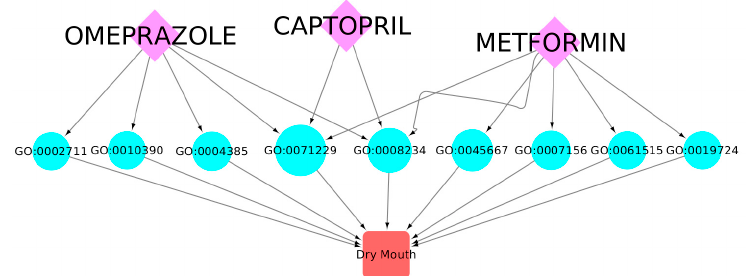
Figure 13. A subgraph of omeprazole, captopril, and metformin and their GO term targets involved in the manifestation of the dry mouth ADR. It may be seen that there are nine different GO terms that, when perturbed by these drugs, may lead to the manifestation of the dry mouth ADR. Three of these GO terms are exclusively perturbed by omeprazole, four exclusively by metformin, and the rest may be perturbed by any of the drugs. Notice there is no GO term that is exclusively associated with captopril.